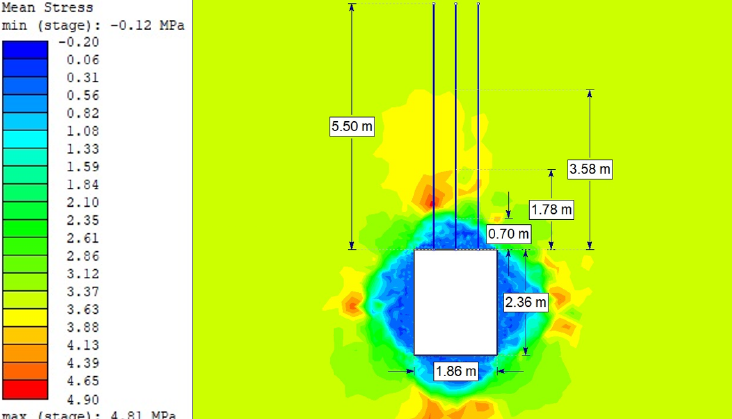
Figure 8. Mean stress for Vernier excavation with full-length anchor bolting (Hoek–Brown criterion).